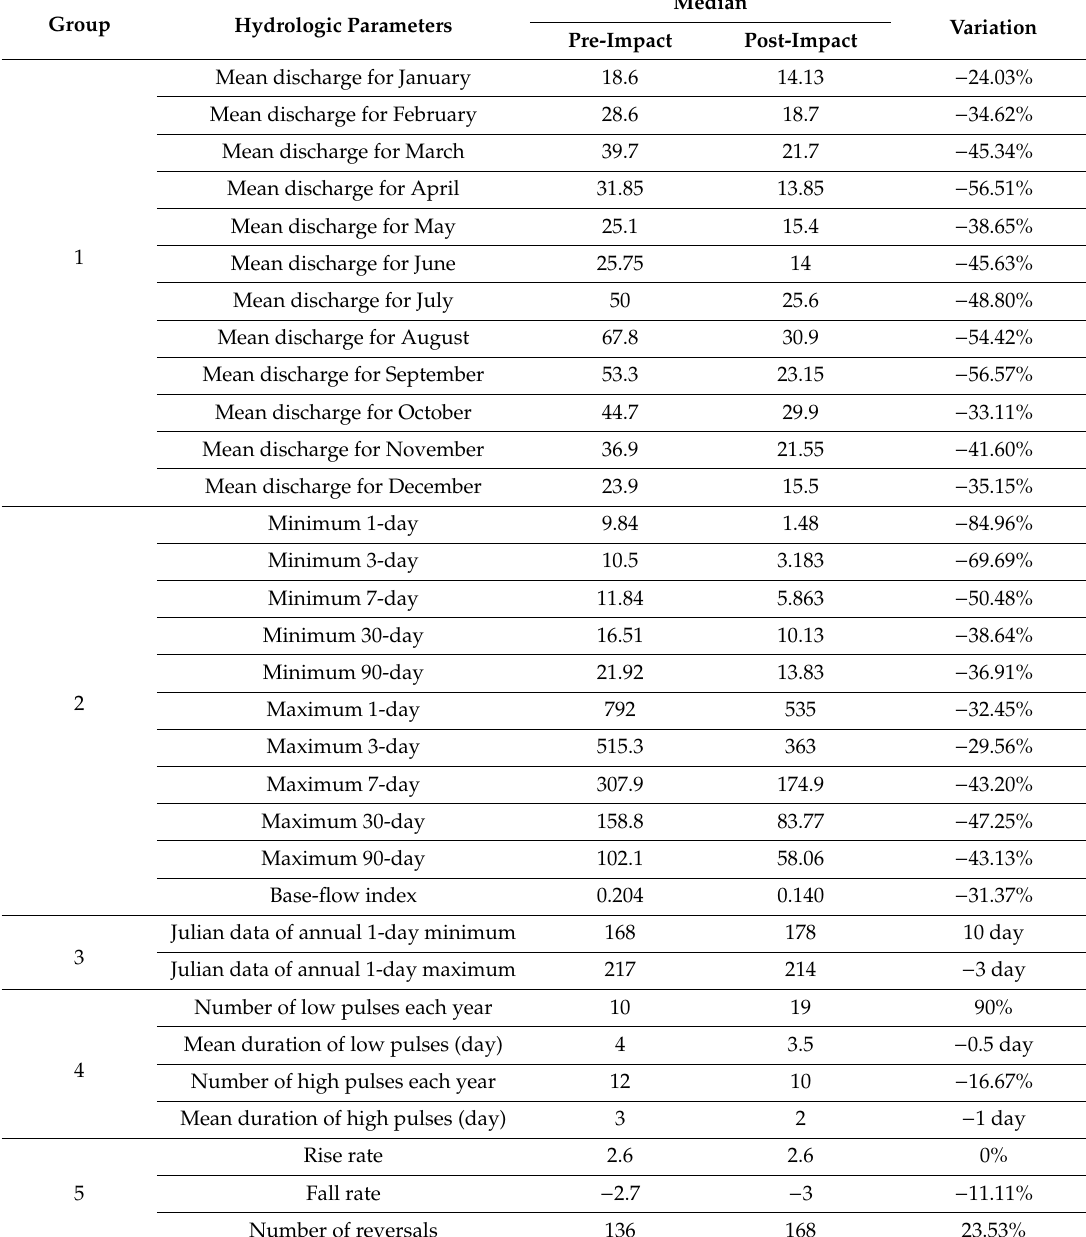
Table 2. Variation and degree of alteration for hydrologic